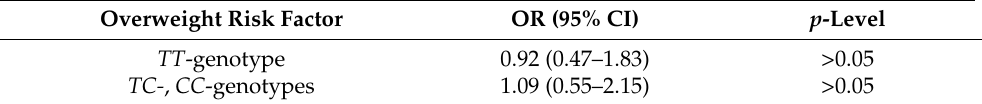
Table 3. The odds ratios of the risk of being overweight depending on the